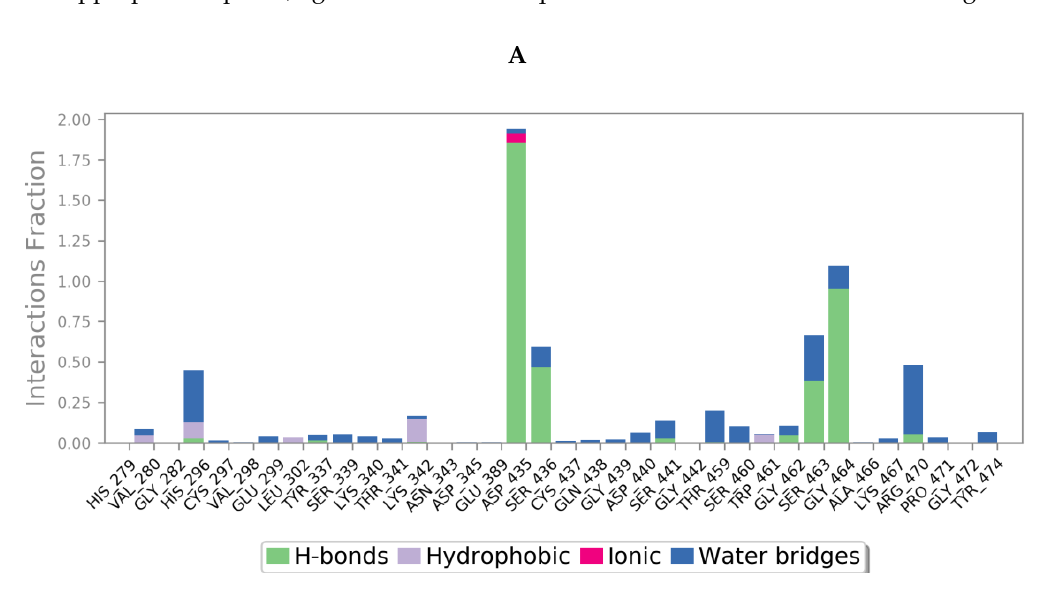
Table 5. Computational binding affinity (ΔG) of the ligand-protein complexes.